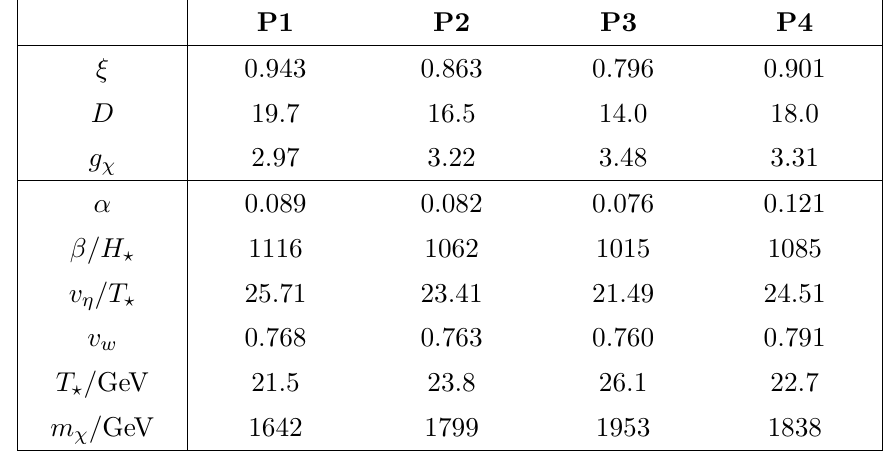
Table 1 . Benchmark points (with λ = 0 . 1 ) for the Scalar Quartic Model that give Ω DM h 2 = 0 . 11